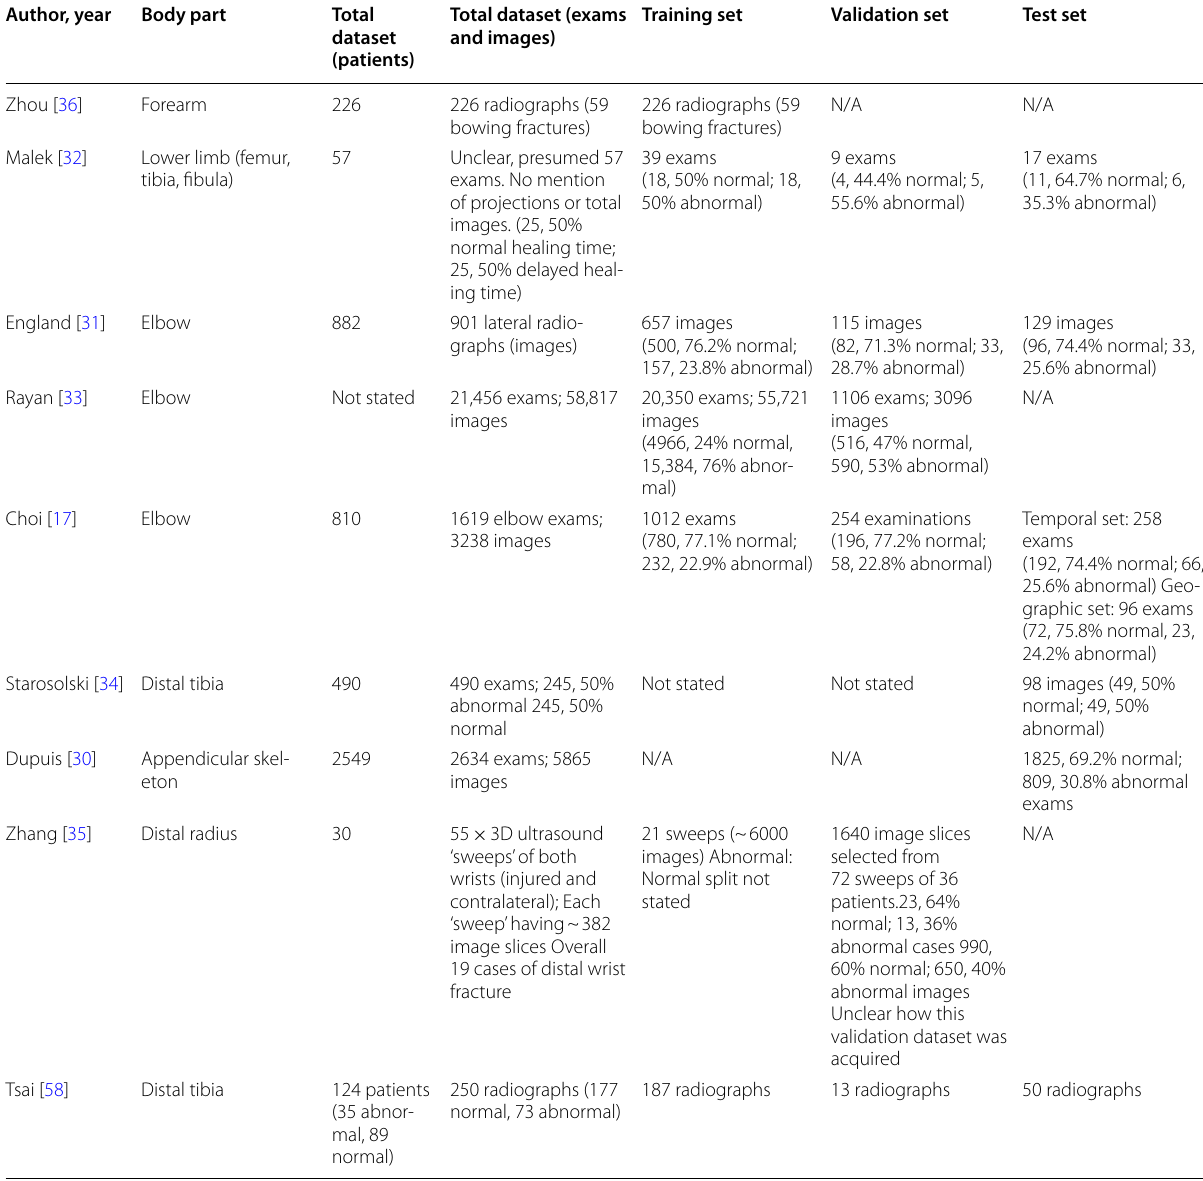
Table 3 Input data demographics and study dataset sizes, organised by publication date Author,